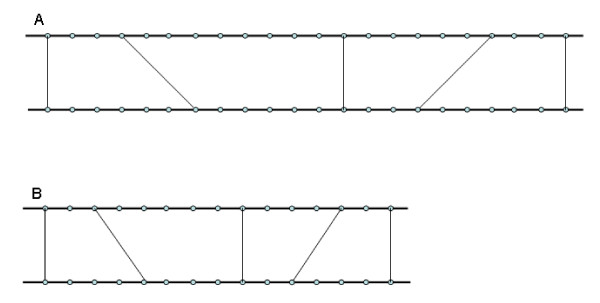
Different distribution pattern of homologous genes in sister regions. Same numbers of homologous genes located in two pairs of sister regions with different size. Homologue pairs are more densely located in (B) than in (A). Dark horizontal lines represent chromosomes, round dots denote genes on chromosomes, lines linking the dots indicate gene homology.